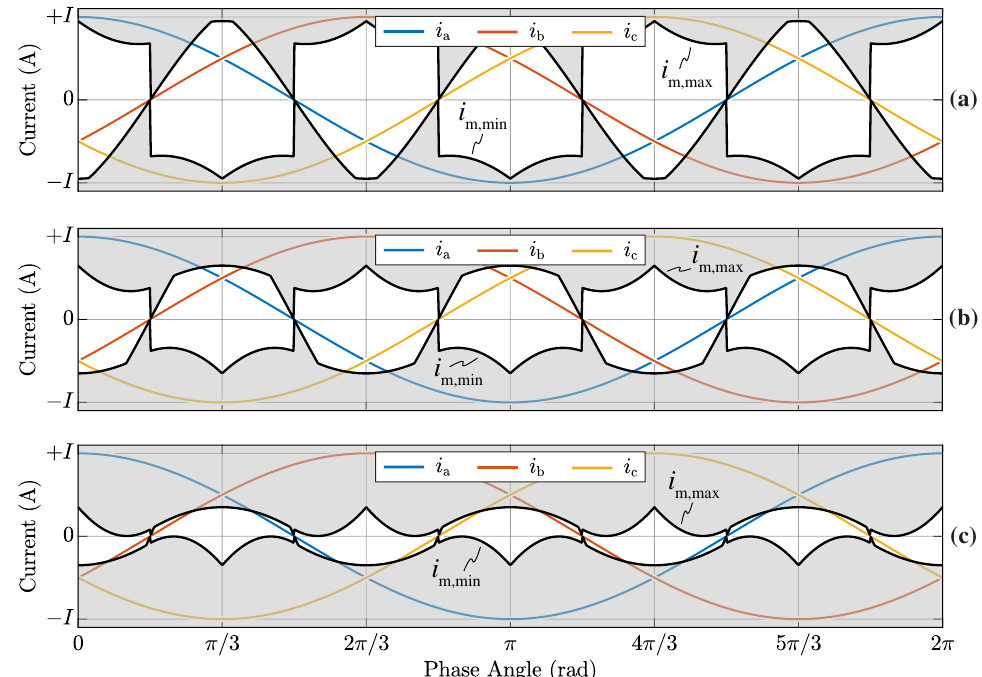
Figure 6. Mid-point current local average limits i m,max , i m,min for M = 0.7 ( a ), M = 0.9 ( b ) and M = 1.1 ( c ) assuming unity power factor operation ( ϕ = 0, i.e., sign ( i x ) = sign ( v x ) ).